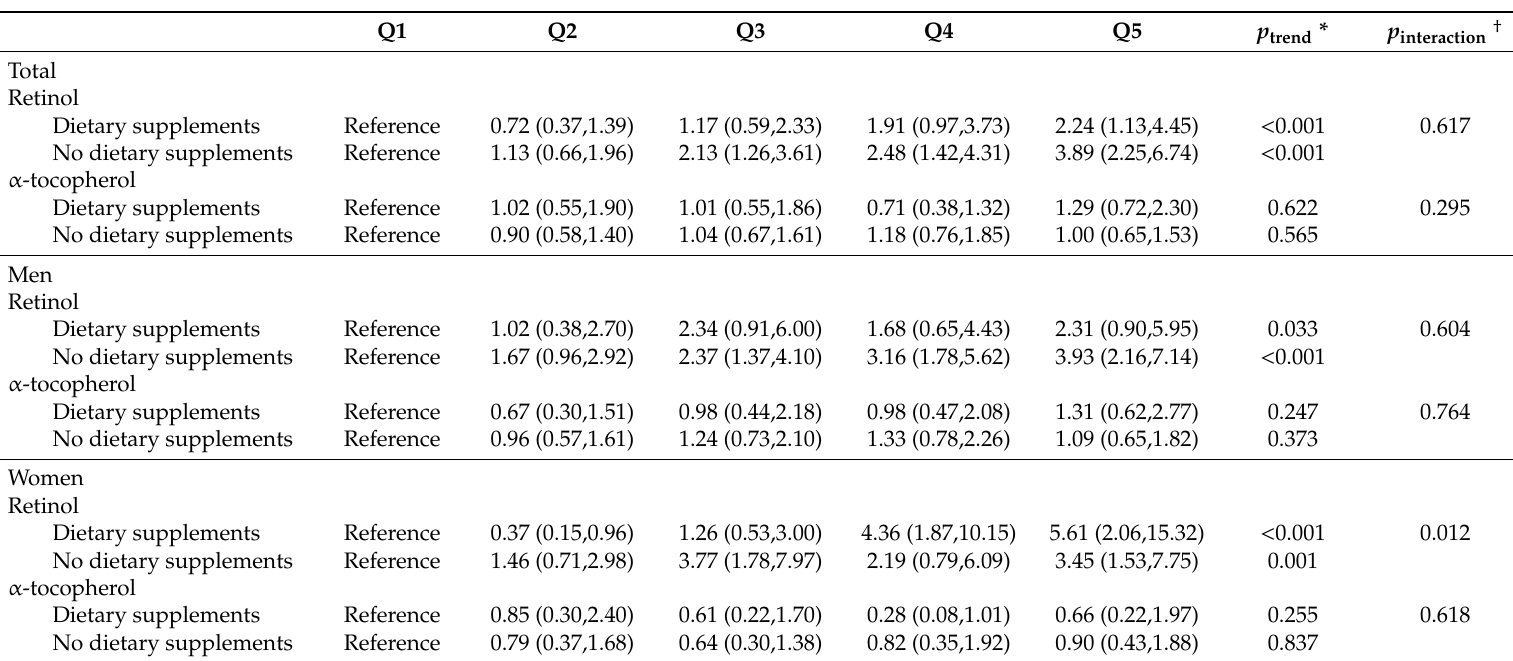
Table 3. Use of dietary supplements stratified association of serum retinol and α -tocopherol concentration with hyperuricemia ‡